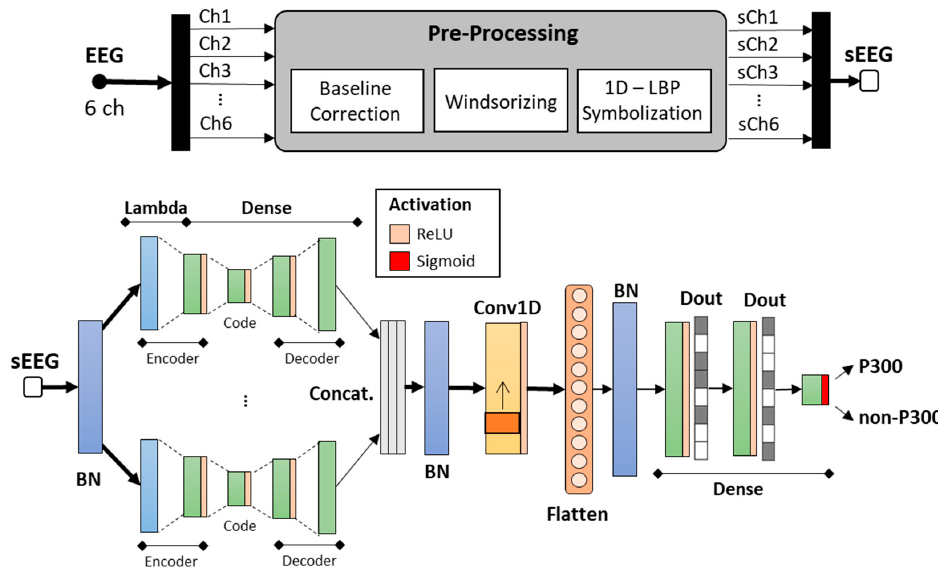
Figure 2. Overall architecture